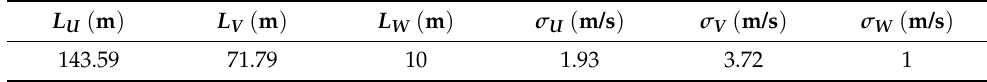
Table 1. Atmospheric turbulence scale and intensity parameter